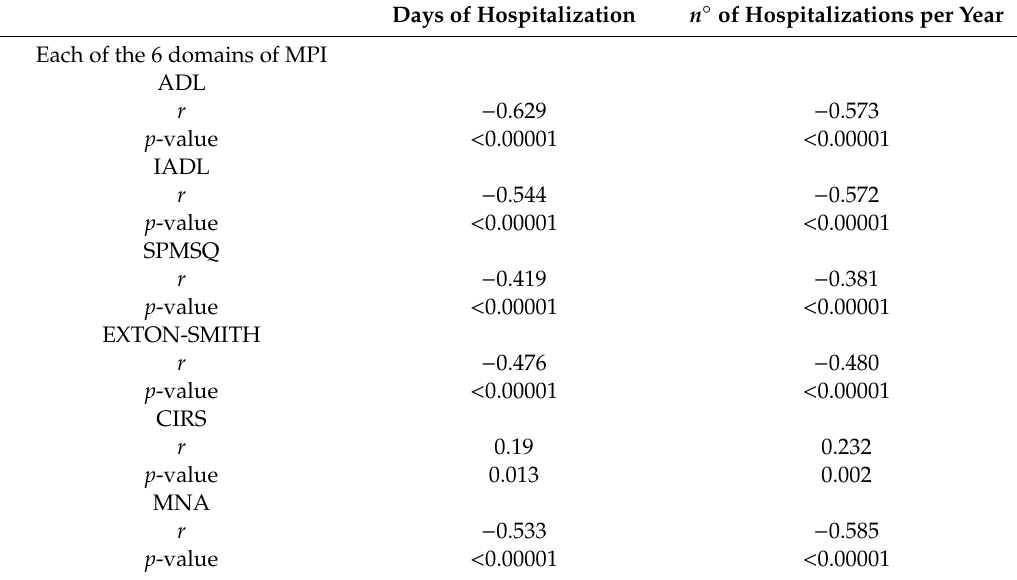
Table 2. Correlations between each of the six domains of the multidimensional prognostic index (MPI) and the days of hospitalization and the number of hospitalizations per year. Days of Hospitalization n ◦ of Hospitalizations per Year